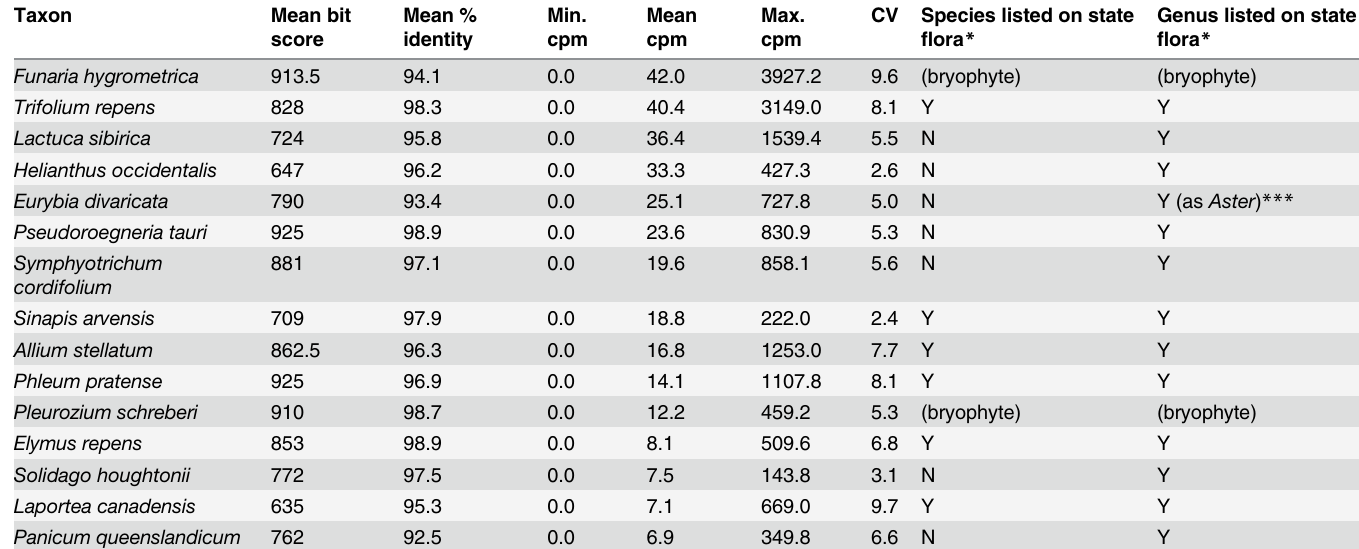
“ environmental sample ” in the associated taxonomy, because these reference accessions do not represent a known taxon and obscure other plausible sources. The second case was the assign- ment of eight OTUs to the tundra grass Dupontia fisheri . These OTUs were re-examined and found to match the common temperate grass genus Alopecurus at a generally higher percentage identity, but HSPs had lower bit scores because the matched Alopecurus accessions were shorter. The mean percentage identity was 96.0% for Alopecurus HSPs (the highest mean of all genera matched by these OTUs) vs. 94.9% for Dupontia HSPs, whereas the mean bit scores of HSPs were 397.6 and 407.2, respectively. We therefore re-assigned all D . fisheri OTUs to Alope- curus , although the combined counts for this genus remained below our 50-count threshold for this data set. In the third case, the Asian species Dioscorea polystacha was initially identified as an OTU assignment. Re-examination of these OTUs revealed that only one Dioscorea polysta- cha accession was an HSP and all other HSPs were with accessions of a phylogenetically very distant species, Raphanus sativa , which is widespread in North America. Submission of